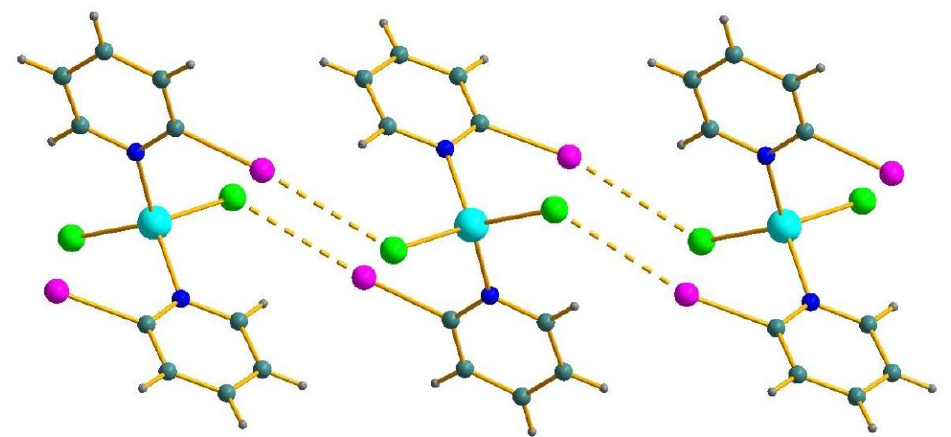
Figure 1. Halogen bonding (dashed) in the structure of 3. I purple, Cl green, N blue, Co cyan, C turquoise, H grey.